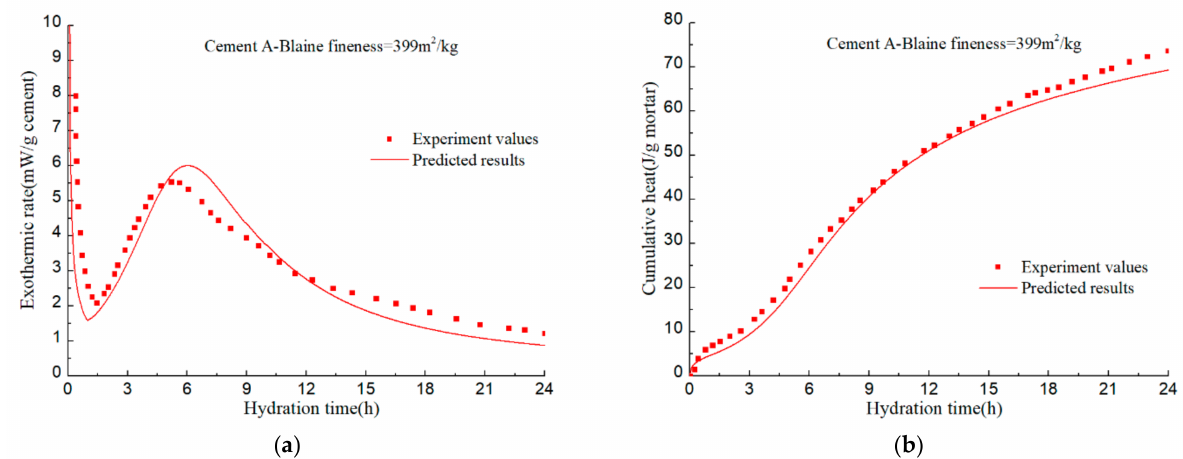
Figure 22. Isothermal calorimetry test and model prediction results of Cement I: ( a ) hydration heat release rate of per unit mass of cement; ( b ) cumulative hydration heat of per unit mass of mortar.